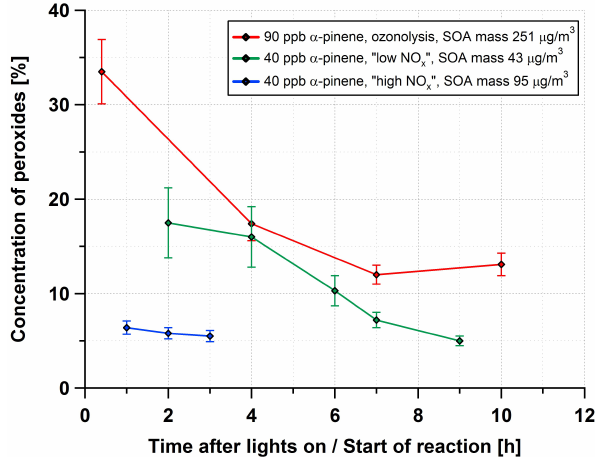
Fig. 6. Measured concentrations of peroxides in the aerosol parti- cles after different reaction times in the smog chamber for ozonoly- sis as well as for photo-oxidation at low and high NO x of α -pinene. An average molecular weight of 300gmol − 1 was assumed for the peroxides. Maximum suspended SOA levels are given in legend. Error estimation includes uncertainties of the absorption measure- ment, sensitivity, solvent volume and aerosol mass. The largest con- tribution to the error is from filter